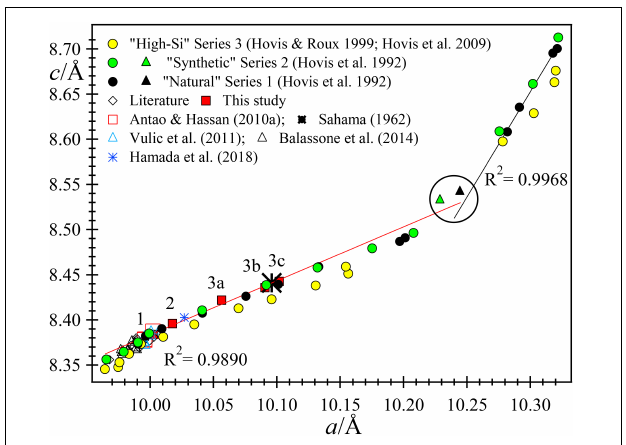
FIGURE 6 | Linear trends between c and a unit-cell parameters for nepheline-kalsilite solid solutions. Most of the natural samples are close to the trend line, but the three ion-exchange series deviate somewhat, particularly series 3. “Literature” sources are given in the text.